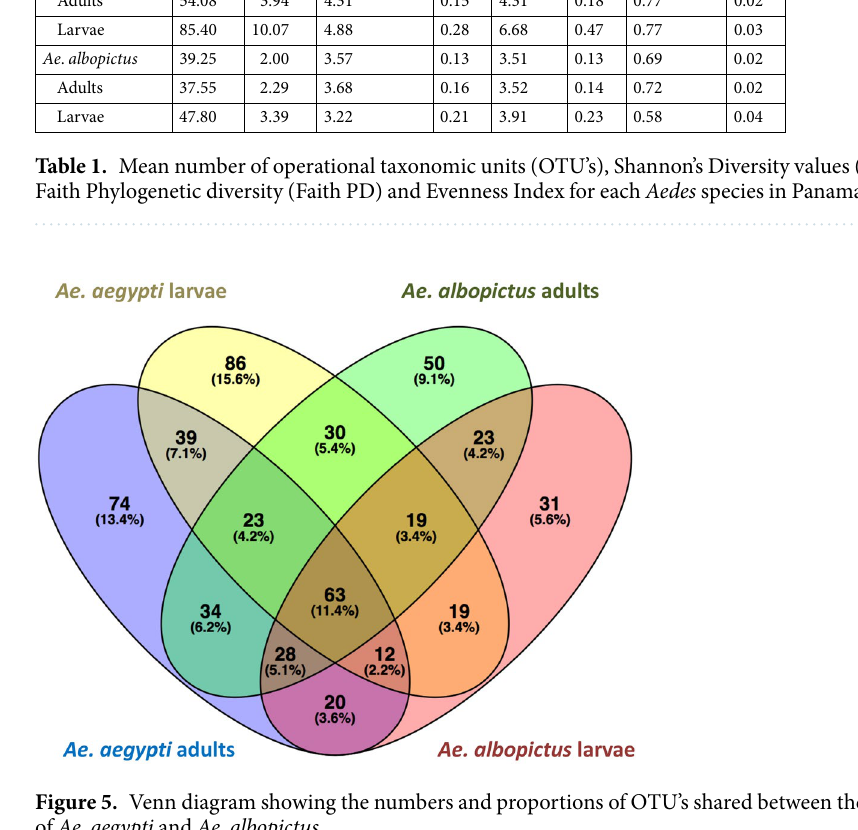
Figure 5. Venn diagram showing the numbers and proportions of OTU’s shared between the adults and larvae of Ae . aegypti and Ae . albopictus .